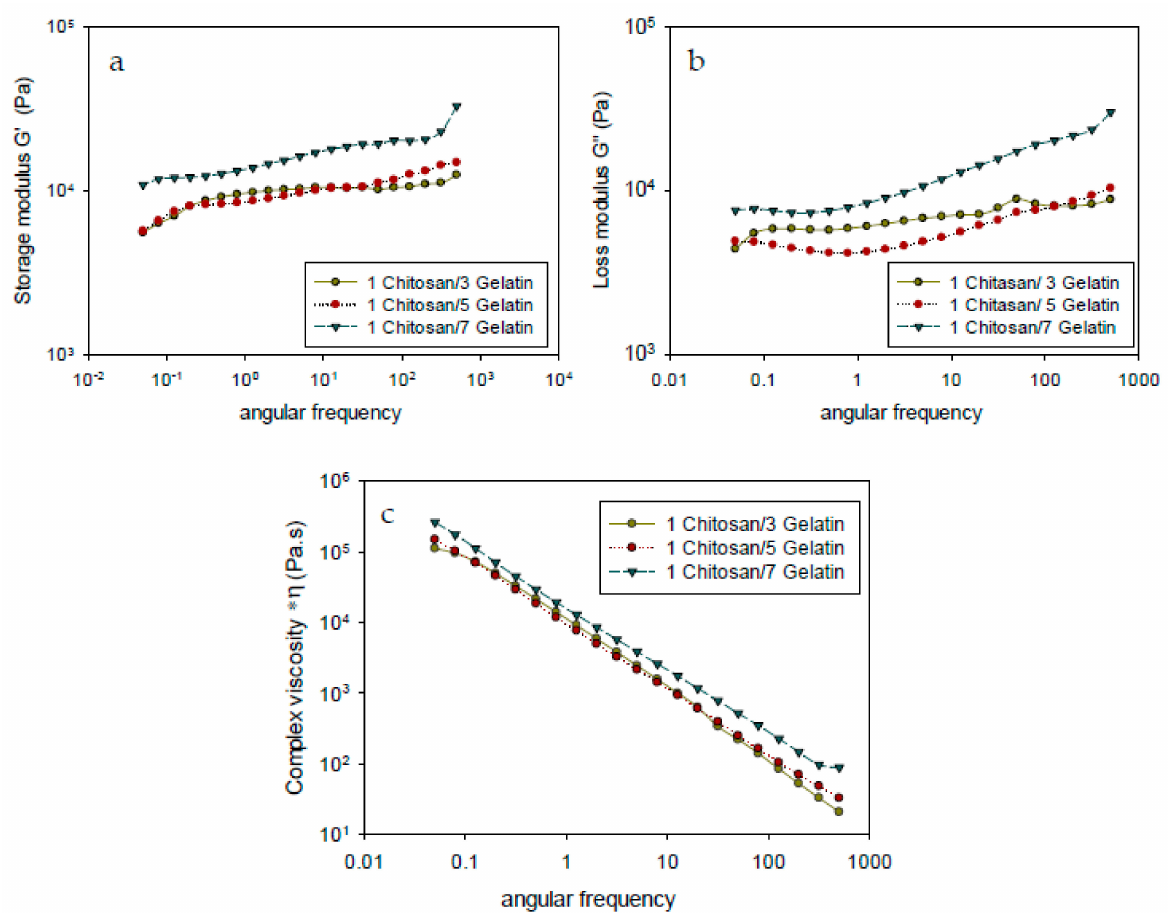
Figure 3. Rheological properties of modified chitosan–gelatin membrane foam with different composition ratios of chitosan:gelatin: ( a ) storage modulus (G’), ( b ) loss modulus (G”), and ( c ) complex viscosity (* η